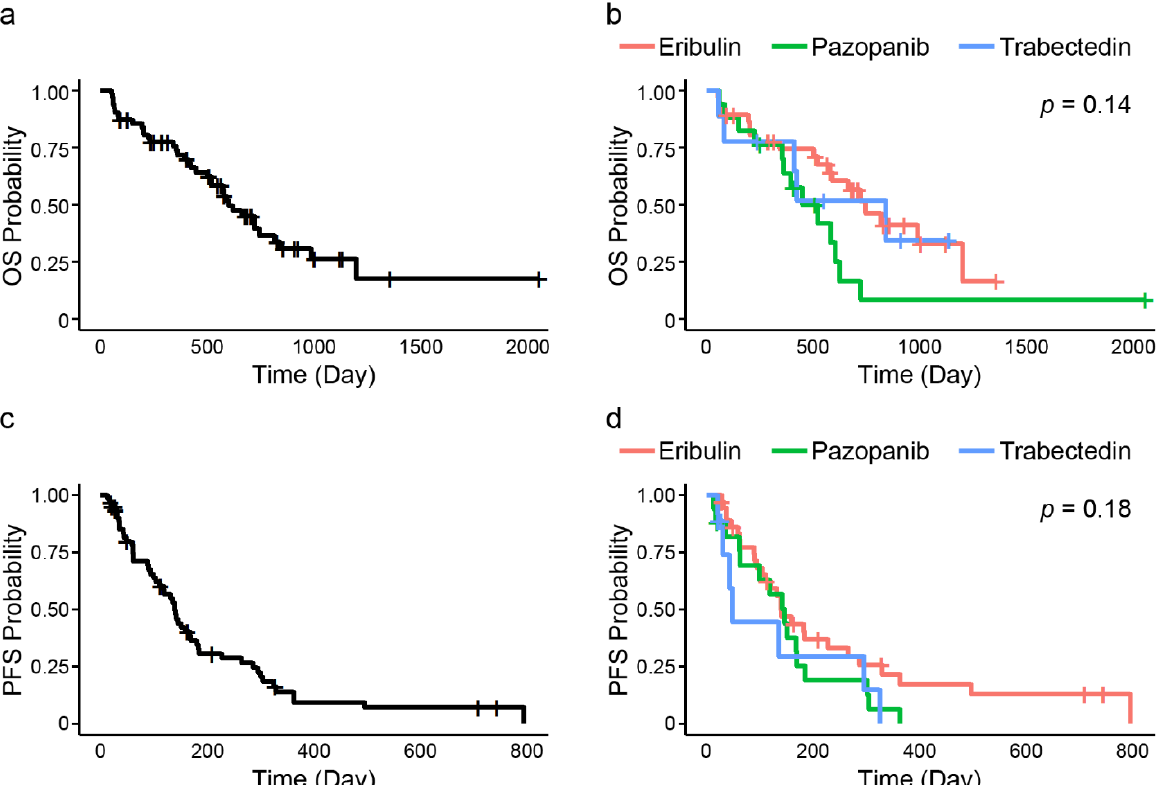
Figure 2. OS and PFS for advanced STSs patients. (a) OS for all STSs patients; (b) Comparison of OS among the first administered drugs. There were no differences among the first administered drugs; (c) PFS for all STSs patients; (d) Comparison of PFS among the first administered drugs. There were no differences among the first administered drugs. Table 2. Univariate analyses of the baseline factors for OS.